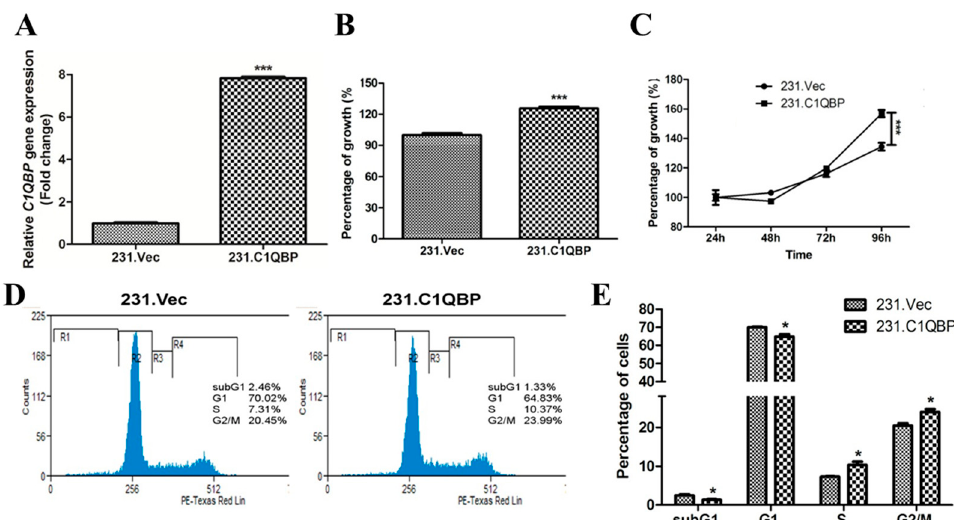
Figure 3. ( A ) C1QBP overexpression in MDA-MB-231 cells. qRT-PCR showed significant up-regu-